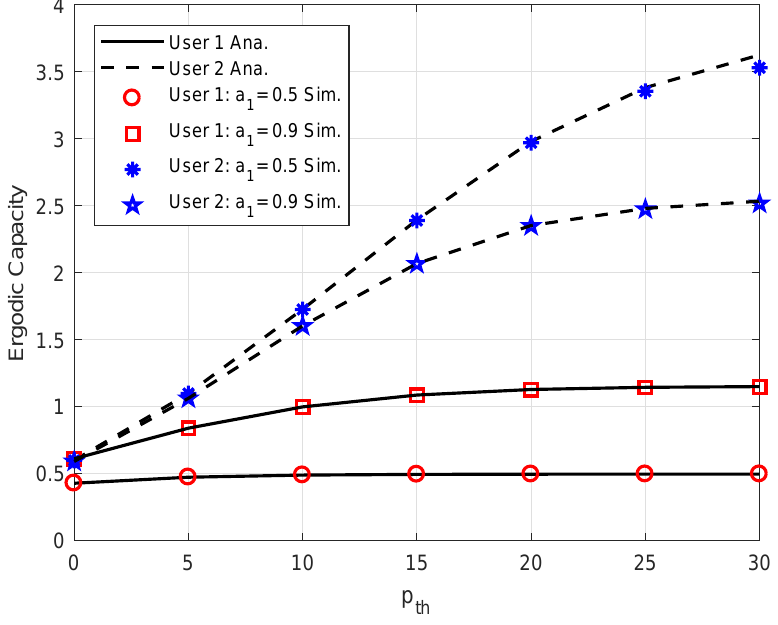
Figure 8. Ergodic capacity of User 1 and User 2 versus p th